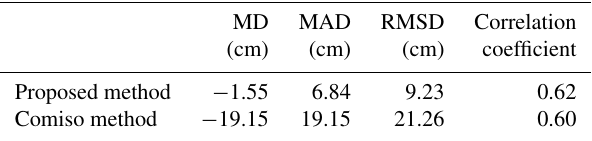
Table 3. The comparisons between the OIB snow depth and the snow depth estimates from our method and the Comiso method in October 2016. MD: mean difference; MAD: mean absolute differ- ence. MD MAD RMSD